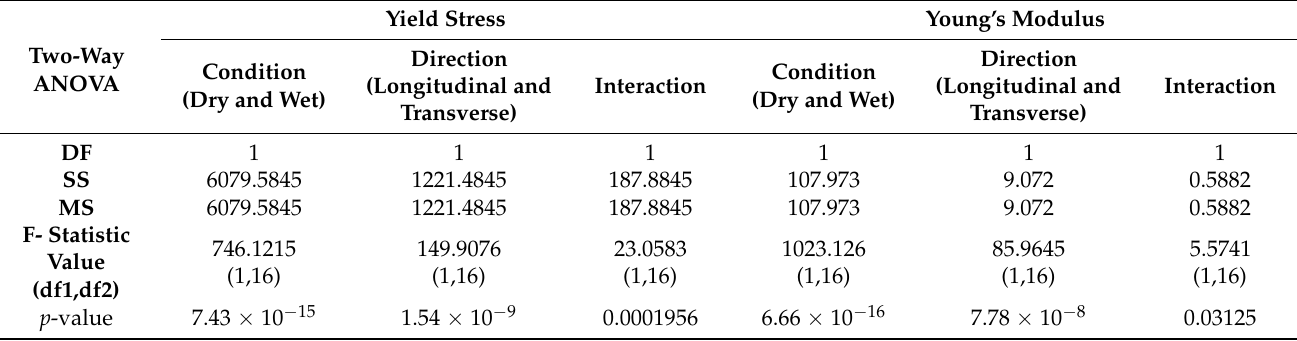
Table 4. Two-way ANOVA results on the tensile properties of Deccani sheep horns-I.